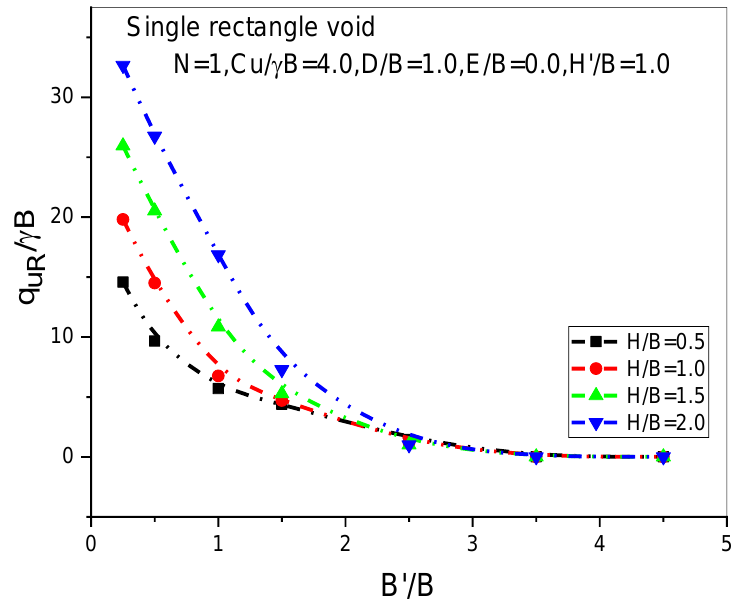
Figure 17. Effect of reinforcement on the ultimate bearing capacity ratio with a change in the void width.